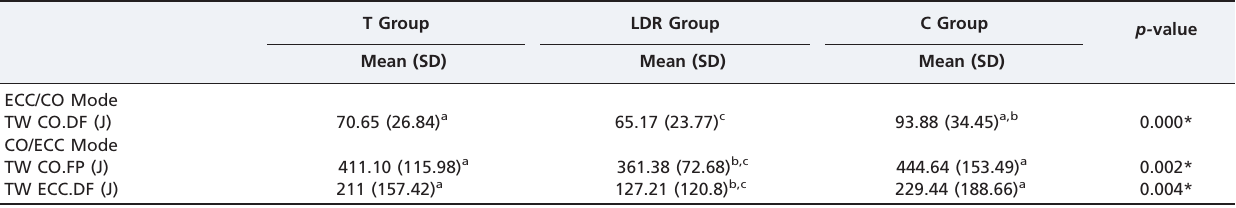
Table 3 - The means (SD) of the isokinetic variables at a velocity of 180 ˚ /s in the eccentric-concentric mode and concentric-eccentric mode and the comparison between the triathlete group, the long-distance runner group, and the control